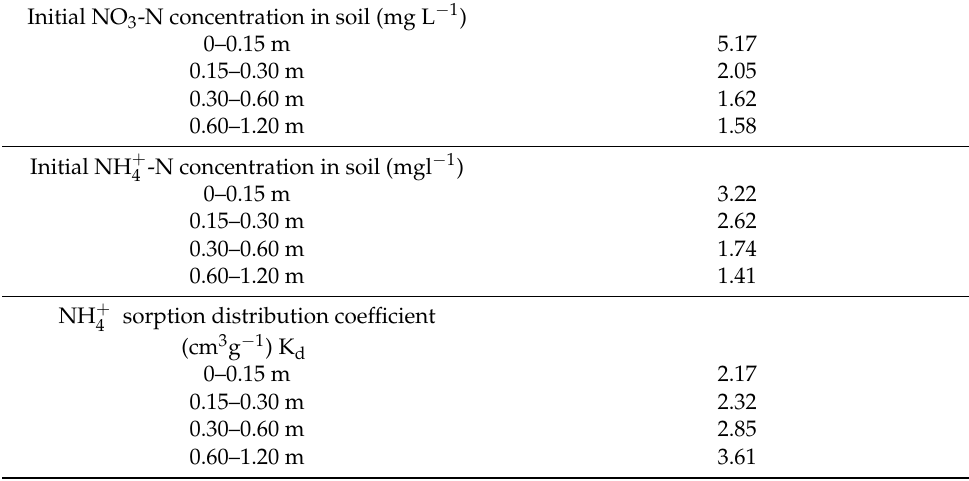
Table 3. Initial nitrogen concentrations in four soil depth ranges at the study